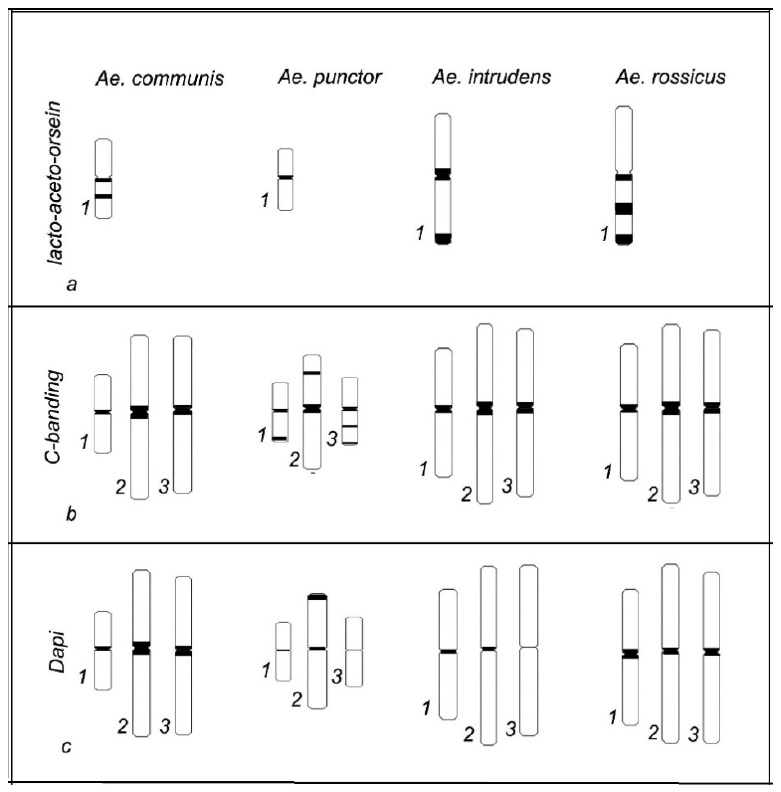
Figure 3. Idiograms of the chromosome banding of Ae. communis , Ae. punctor , Ae. intrudens , and Ae. rossicus : ( a ) lacto-aceto-orcein patterns on chromosome 1; ( b ) C-banding; and ( c ) DAPI: 1, 2, and 3 denote chromosomes 1, 2, and 3, respectively.